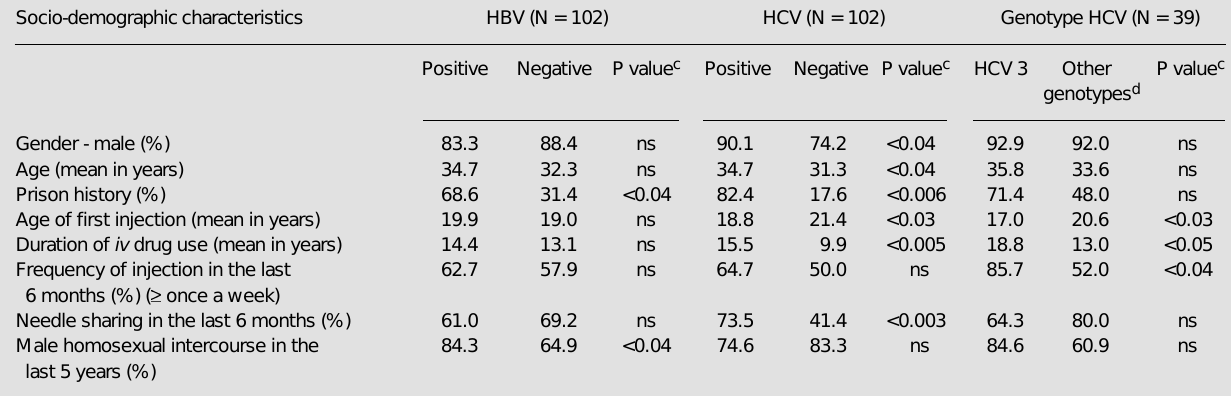
Table 3 - Main associations between socio-demographic characteristics, parenteral and sexual risk behaviors and infection rates for HBV a and HCV b infections and HCV genotypes among IDUs from Rio de Janeiro, Brazil (1994-1996). a HBV infection was defined by the presence of anti-HBc with or without any other HBV serological marker. b HCV infection was defined by the presence of anti-HCV. c Data were analyzed statistically by the t -test for means and chi-square/Fisher’s exact test for frequencies. d Fourteen and 3 subjects were infected with HCV genotype 1 and HCV genotype 2, respectively. ns, Not significant. Socio-demographic